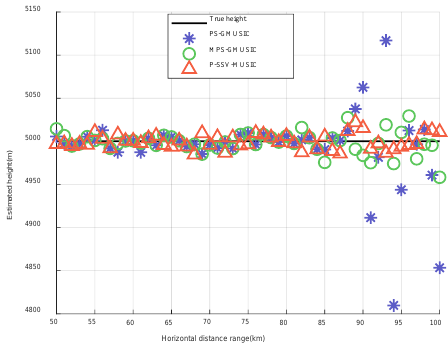
Figure 10. Height measurement results of target.